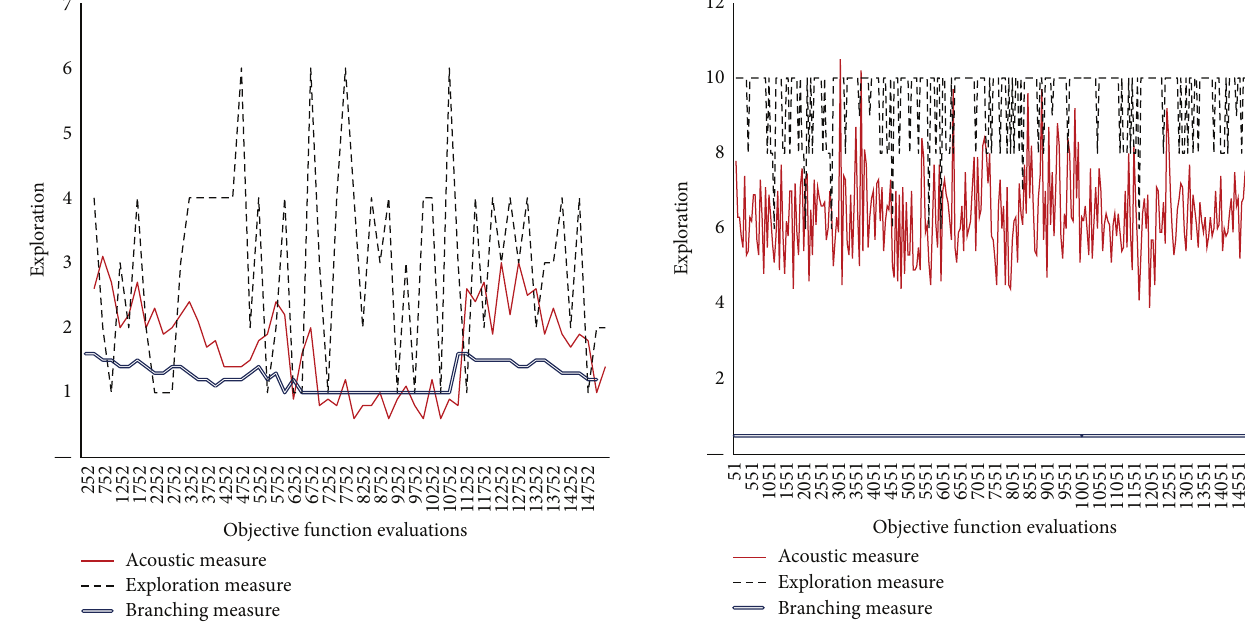
Figure 5: Evaluating ACO ustic against traditional indicators in ACO for the TSP instance d198 with nearest neighborhood thresh- old = 𝜖 6.